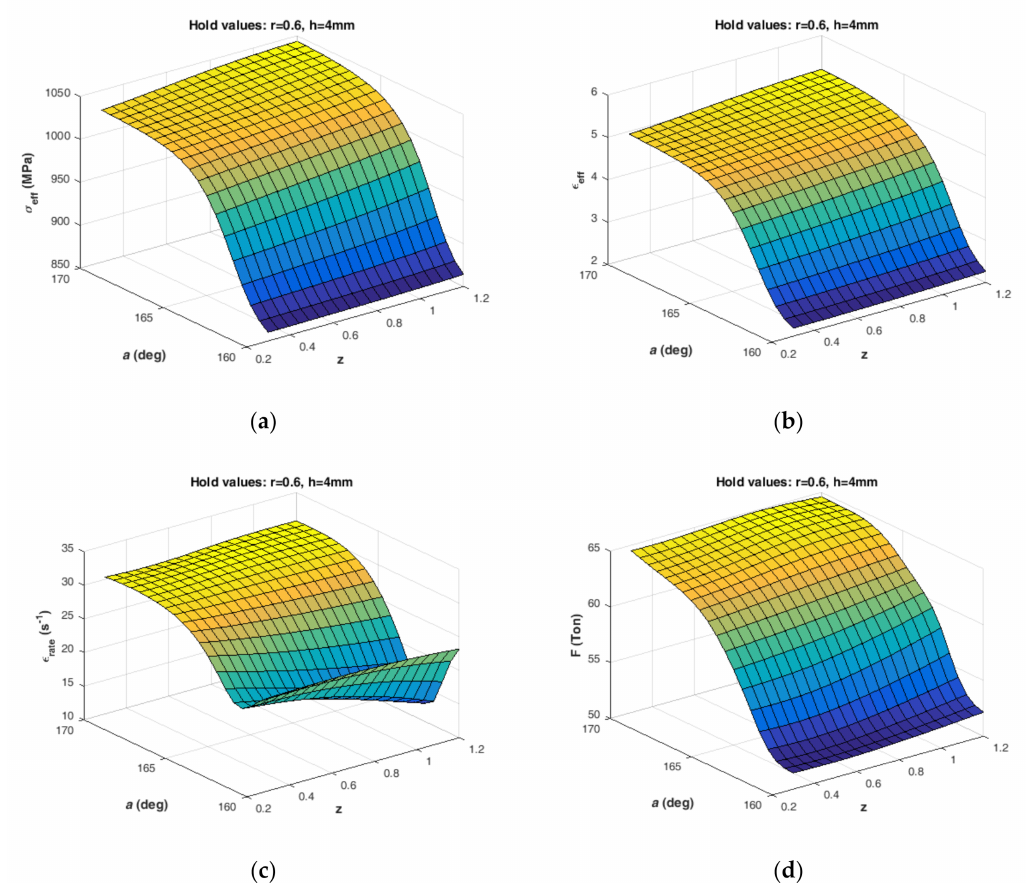
Figure 12. Interaction e ff ect of billet size ratio and punch angle on forming behavior: ( a ) e ff ective stress; ( b ) e ff ective strain; ( c ) e ff ective strain rate; and ( d ) punch